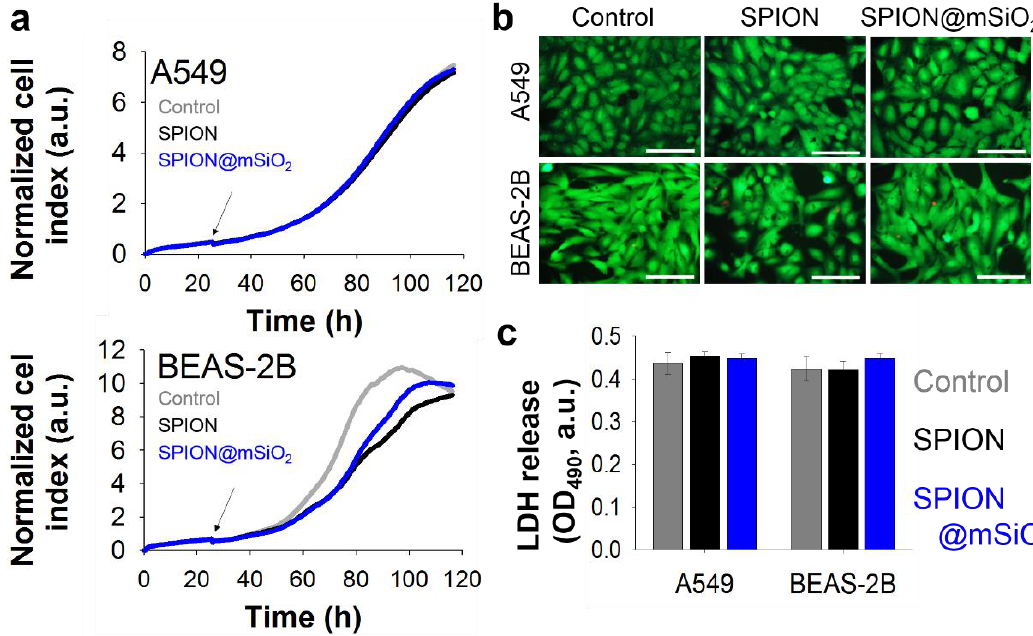
Figure 6. Proliferation profiles (arrows indicate addition of nanoparticles) ( a ), live / dead images (scale bar = 100 μm) ( b ) and lactate dehydrogenase (LDH) release ( c ) of A549 and BEAS-2B cells incubated with 10 µg/mL SPIONs or SPION@mSiO 2 for 3 days.